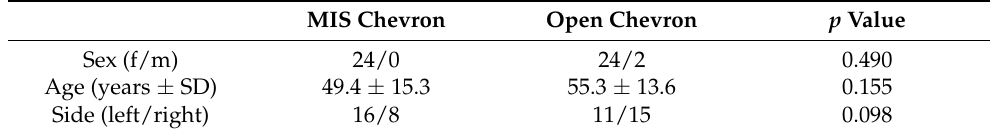
Table 1. Baseline characteristics.